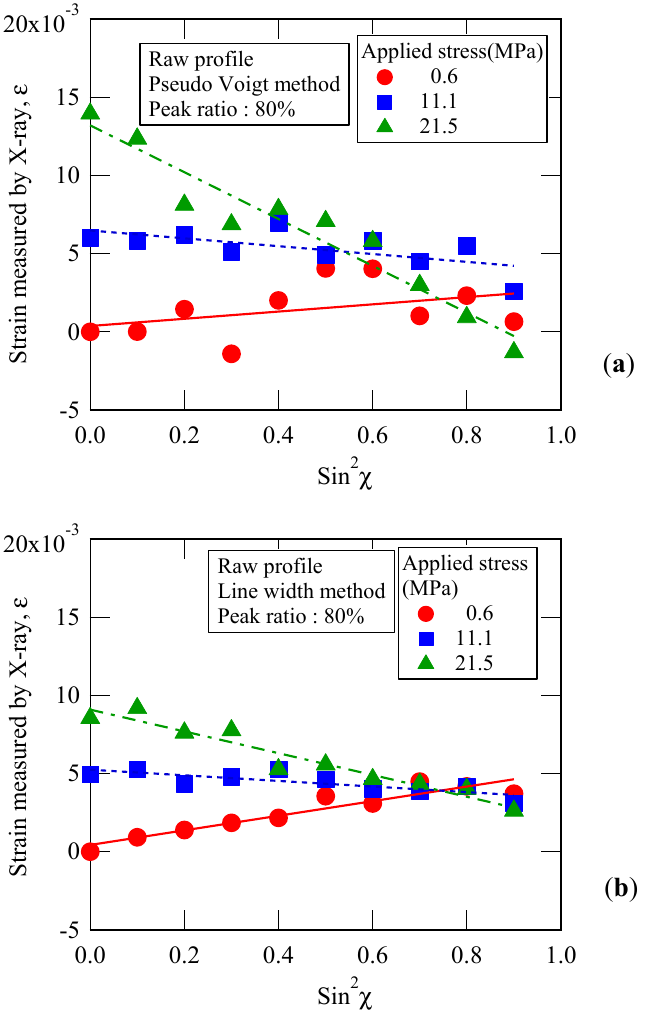
Figure 9. Change of strain measured by X-ray due to rotation of specimen around the χ -axis for the peak ratio of 80%: ( a ) Pseudo Voigt method; ( b ) Diffraction line width method.